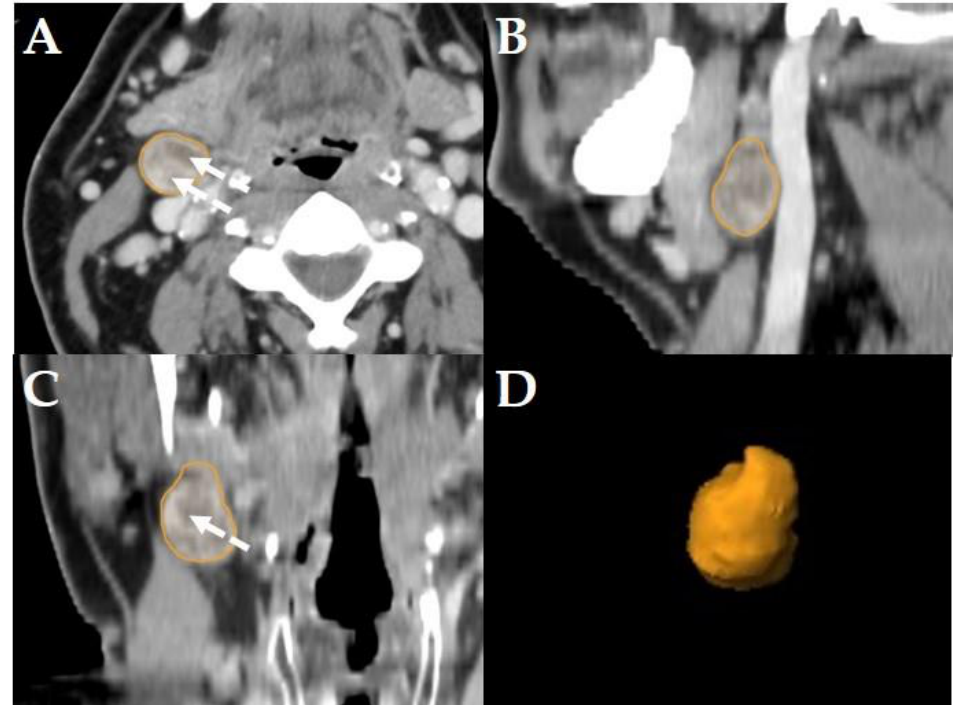
Figure 2. Example of a LN classified as “pathologic” in a staging-CT of a 55-year-old, male HNSCC patient with a tumor of the oral cavity staged cT4a cN2b cM0. Original segmentation in the axial plane ( A ); sagittal ( B ) and coronal ( C ) reformatted views and three-dimensional rendering ( D ) of the LN are provided by the software. Dashed arrows show central necrosis; no soft tissue infiltration and irregular LN capsule was observed.